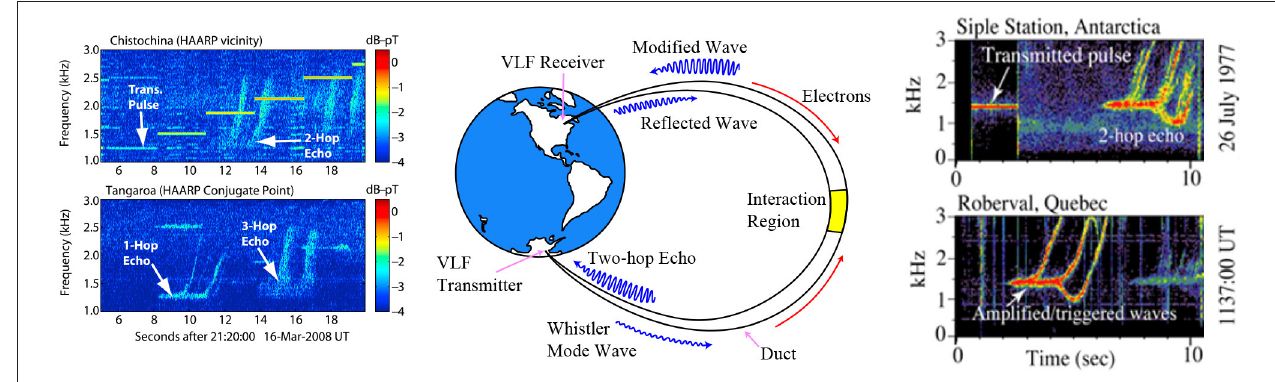
FIGURE 1 | Propagation and amplification of whistler waves along ducted paths for fixed transmitter/receiver locations. Spectrograms of transmitted and received signals from HAARP (Left) and Siple (Right) transmitters are shown. Adapted from Figure 1 of Gołkowski et al.